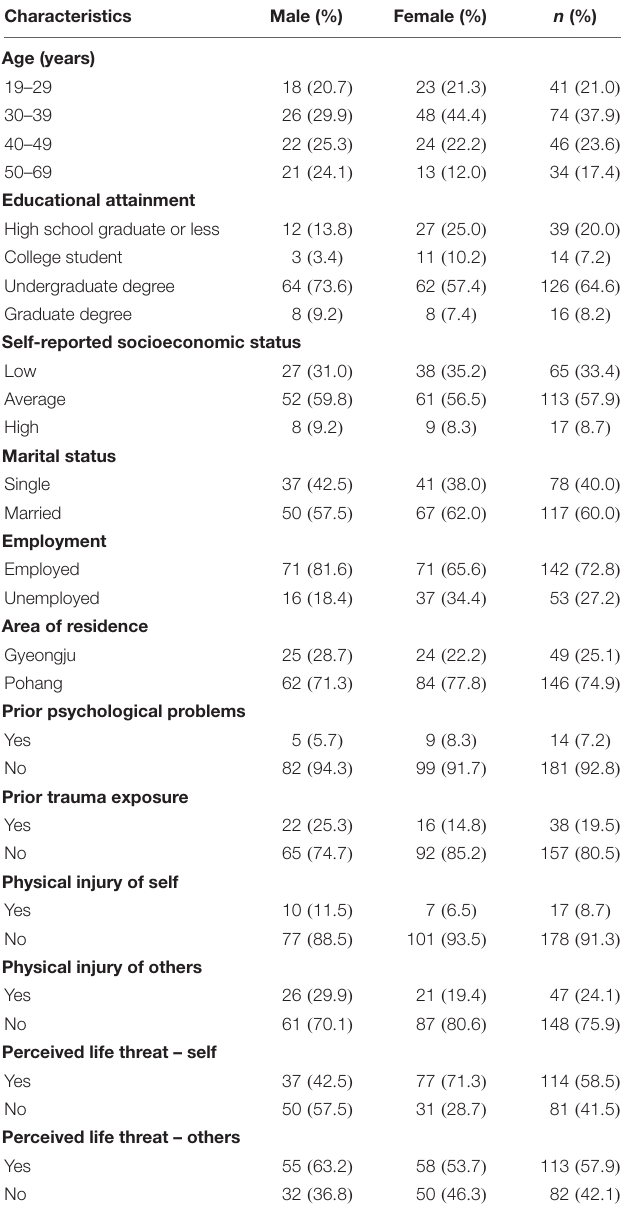
TABLE 1 | Demographic and disaster-related characteristics of participants ( N =